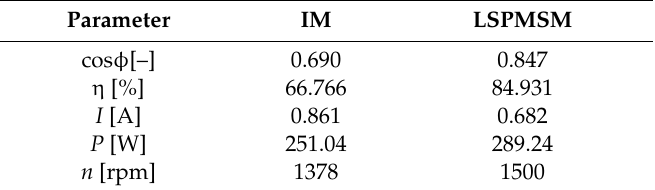
Table 4. Comparison of selected parameters during laboratory test for T l = 1.73 Nm.